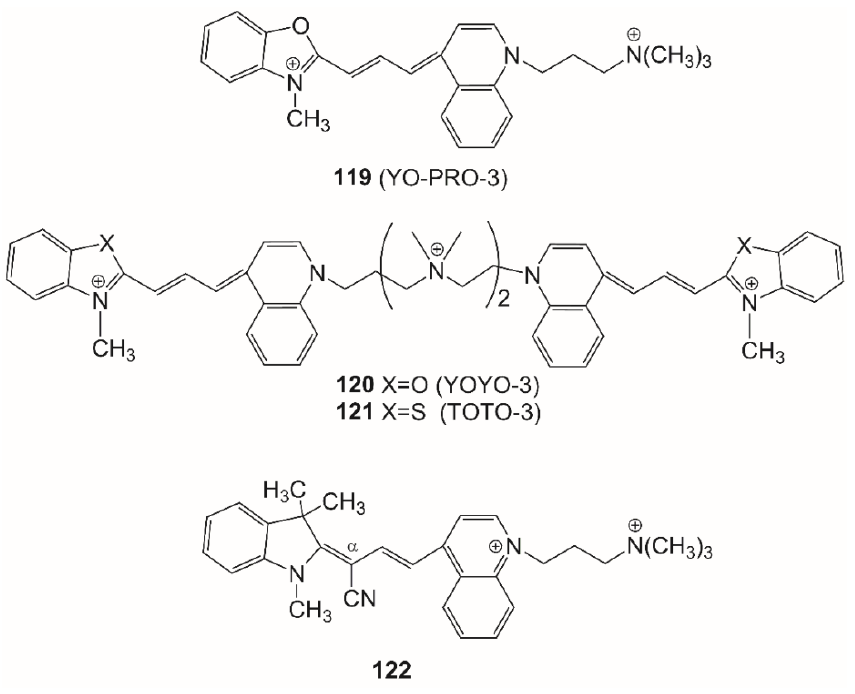
Figure 25. Structures of trimethine cyanines 119–122 .